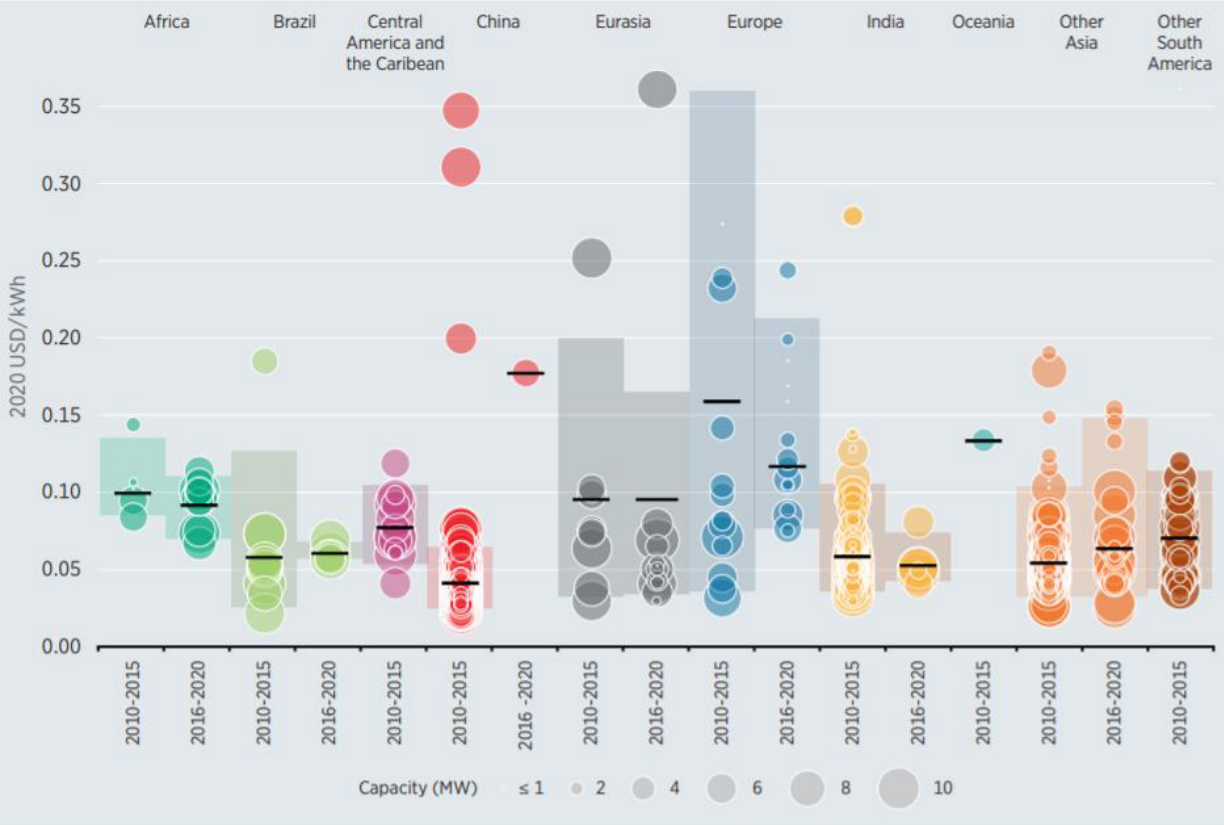
Figure 13. Total installed cost for small hydropower plants by country/region, 2010–2020 [82].